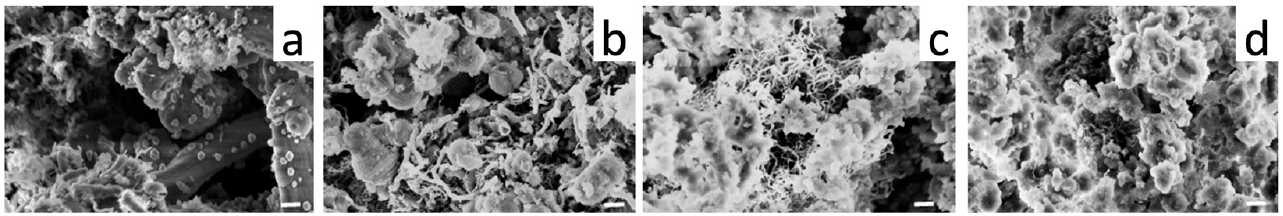
Figure 8. Nanocarbon filaments formation over: ( a ) Ni/MCM-41, ( b ) Ni/0.02Ce-MCM-41_US, ( c ) Ni/0.04Ce-MCM-41_US and ( d ) Ni/0.06Ce-MCM-41_US after 6 h on reaction stream (Bar length = 200 nm, magnification 100 kX).